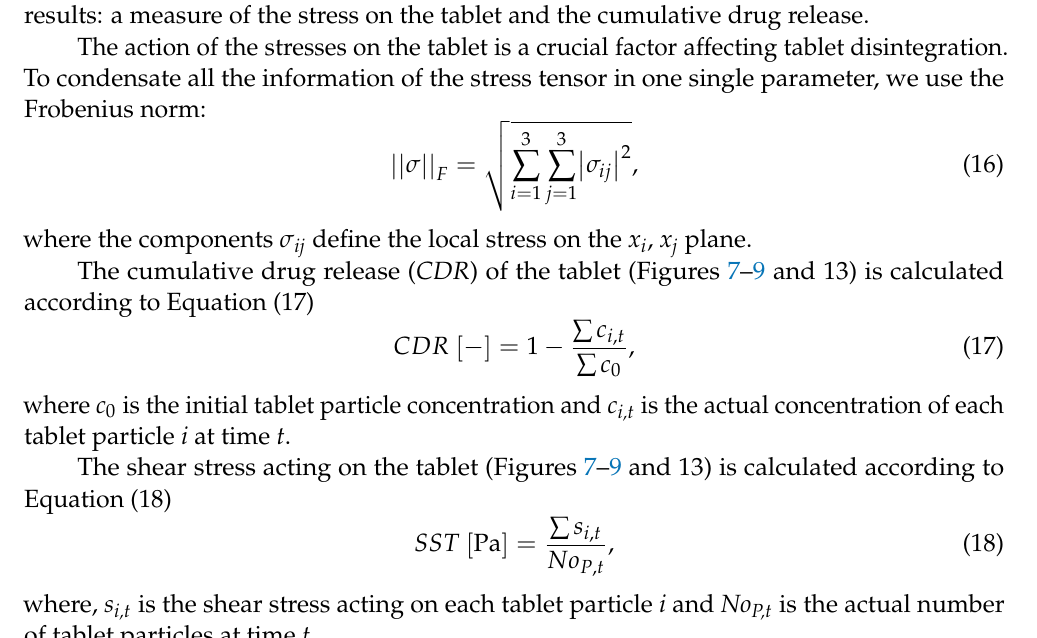
Figure 6. Representation of the initial position of the tablet, which is in all models identical.